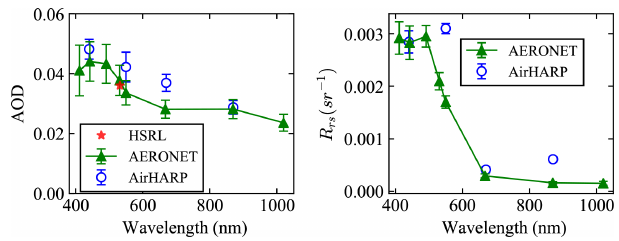
Figure 20. Comparisons of the AOD and R rs from AirHARP re- trievals with AERONET products. The retrieval results are aver- aged with 4 × 4 pixels (2 . 2km × 2 . 2km) around the AERONET USC_SeaPRISM site. This is similar to Figs. 18 and 19, with er- ror bars indicating the standard deviations, but only pixels with χ 2 < 2 are considered. The AERONET AOD and R rs spectra are taken from 23 October 2017, with the error bars indicating daily variations. HSRL AOD at 532nm is also